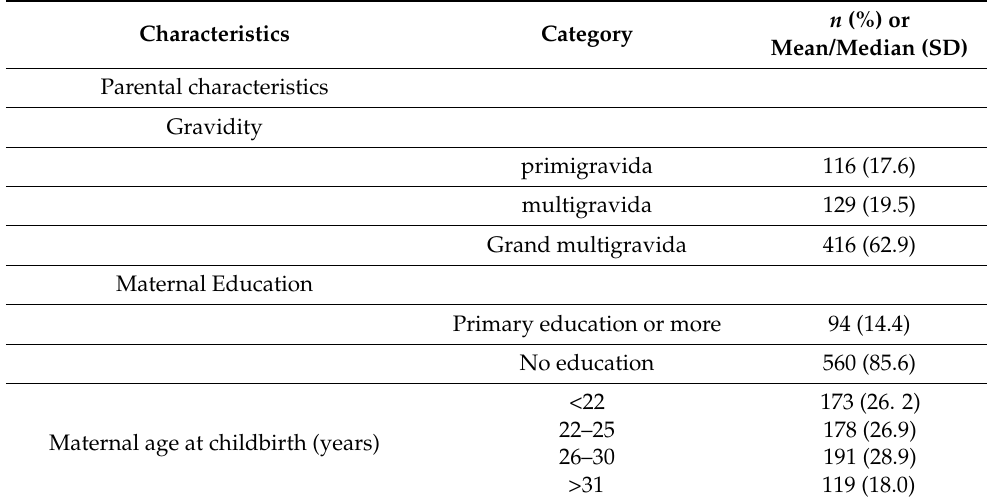
Table 1. Study population characteristics ( n =